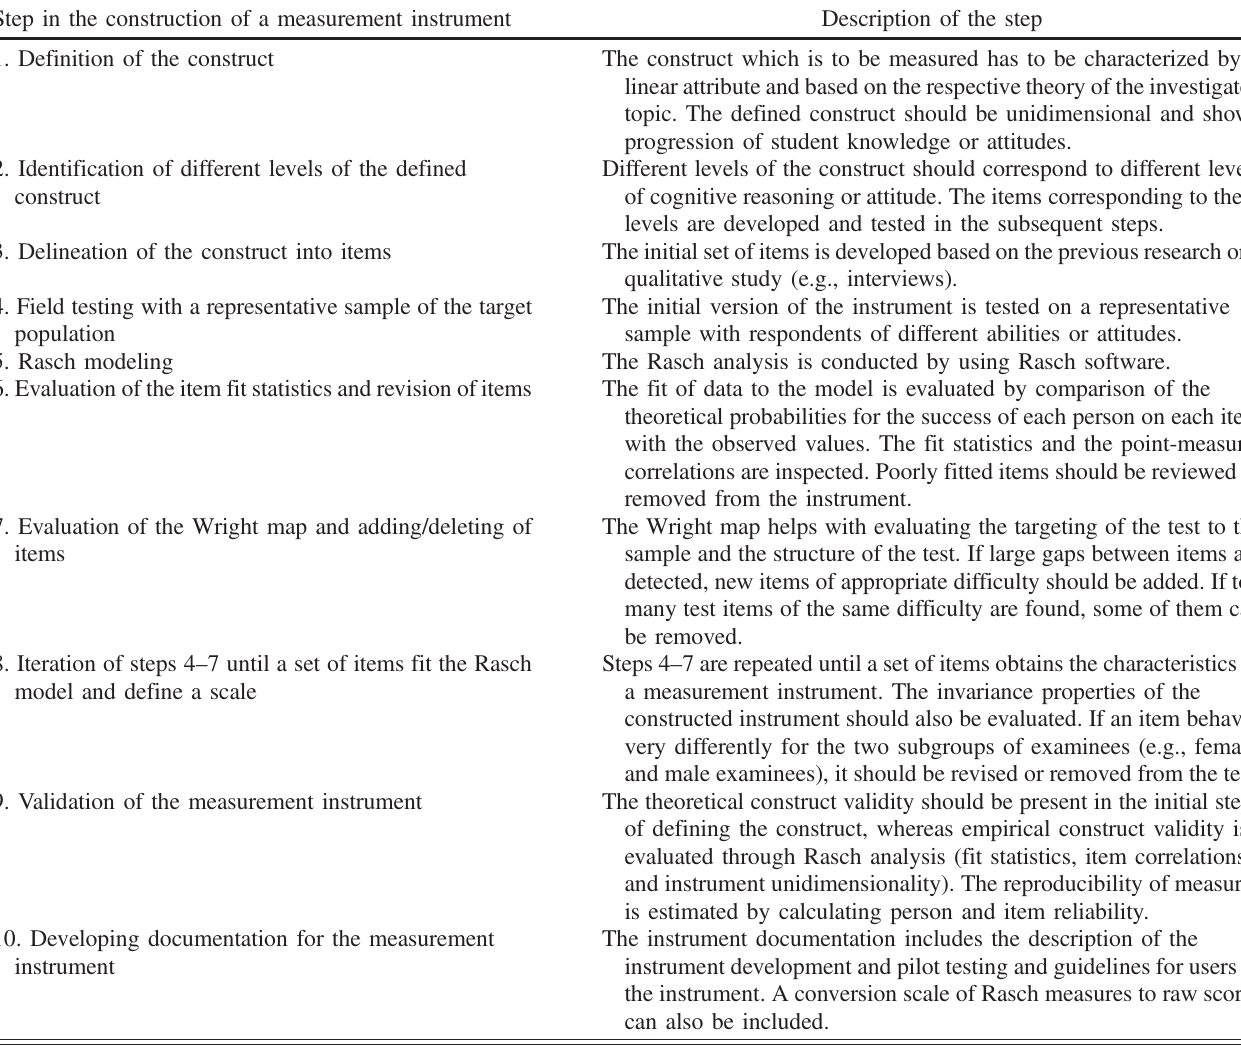
TABLE II. Short description of the steps in the construction of a measurement